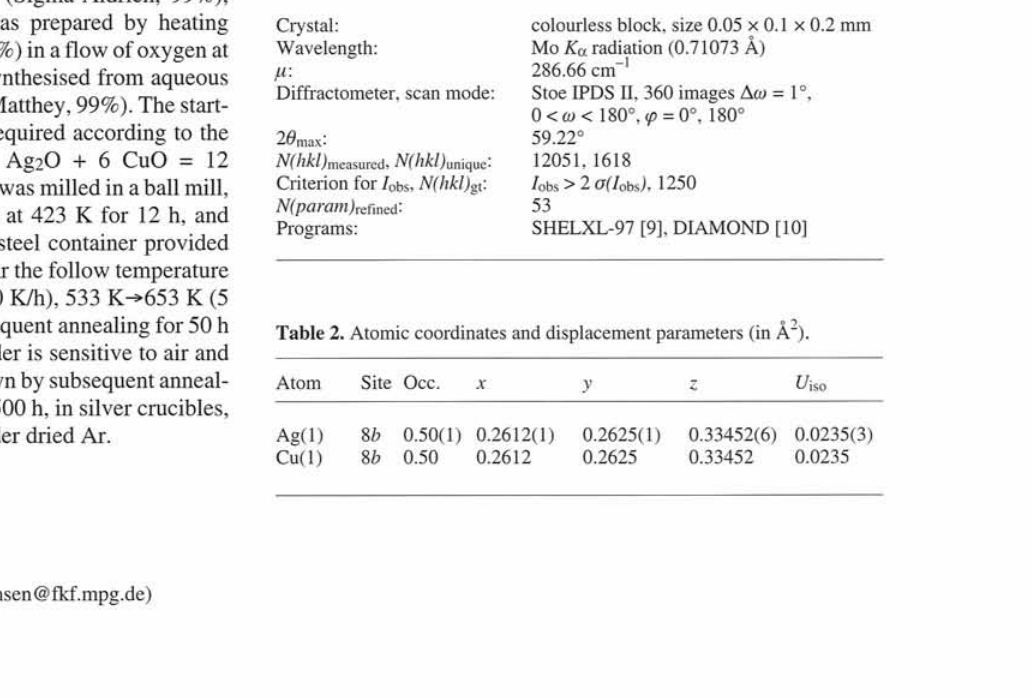
Table 2. Atomic coordinates and displacement parameters (in À 2